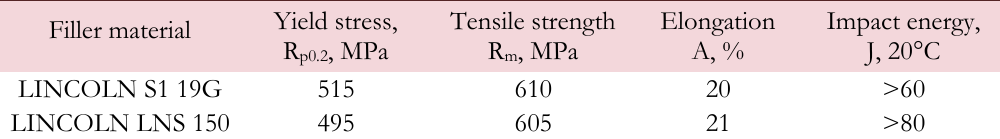
Table 4: Mechanical properties of filler